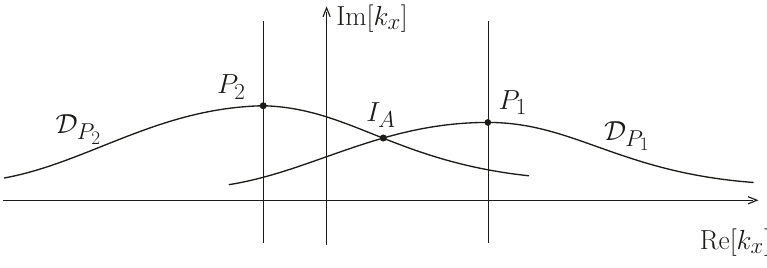
Figure 12 . Multiple thresholds with di(cid:11)erent external momenta p and q